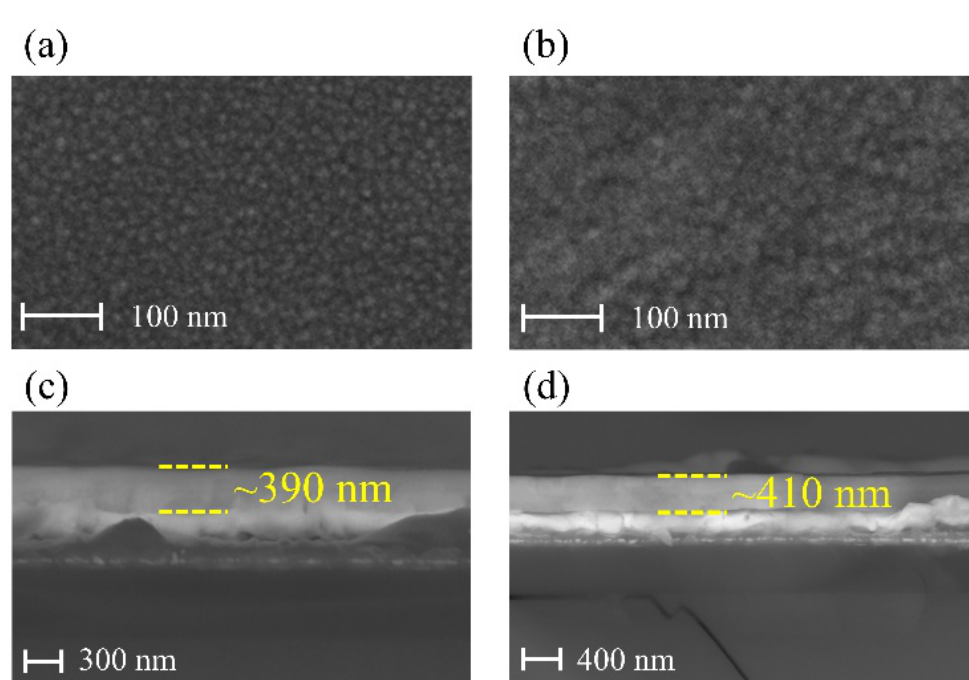
Figure 3. Surface morphologies for ( a ) up-graded and ( b ) down-graded PLZT thin films. Cross section morphologies for ( c ) up-graded and ( d ) down-graded PLZT thin films.